Question: Write a caption explaining this figure to a reader.
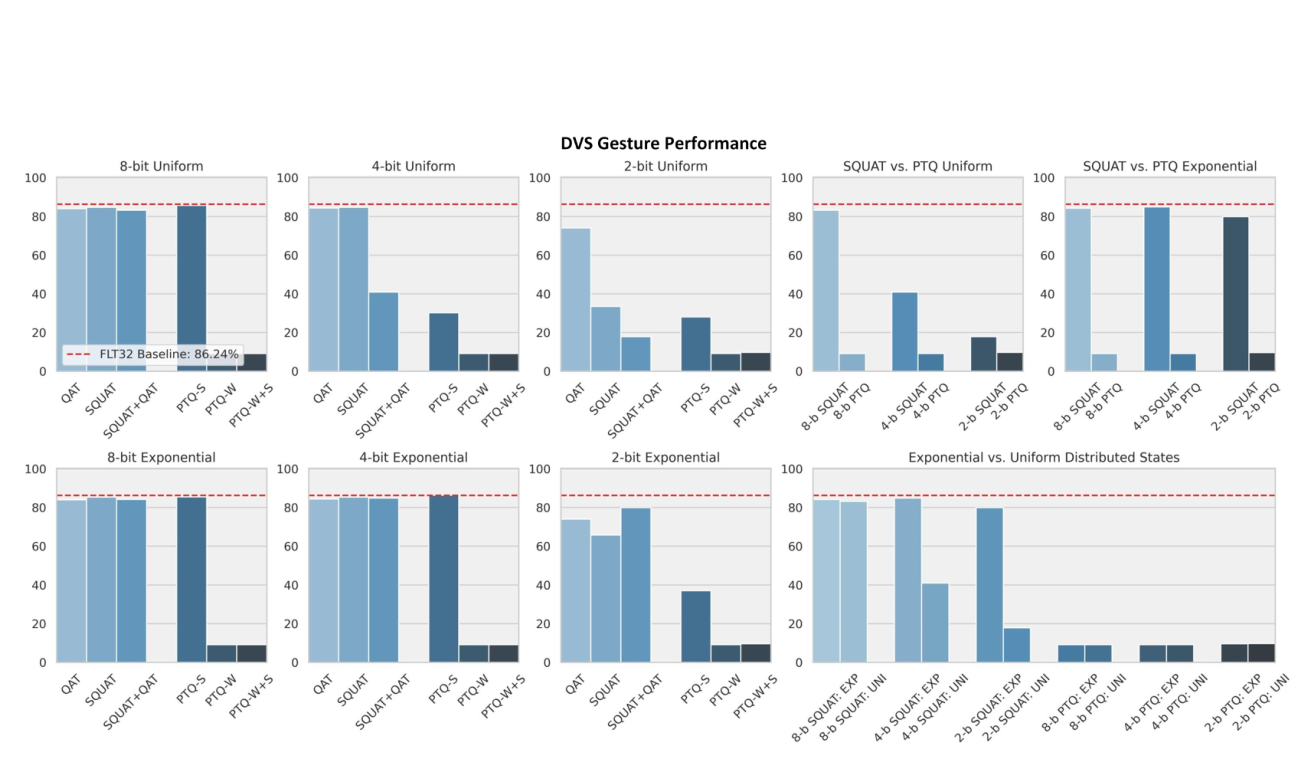
Answer: DVS Gesture Dataset performance. Top row: (i) 8/4/2-b uniformly distributed states across QAT (N-b weights, flt32 states), SQUAT (flt32 weights, N-b states), SQUAT+QAT (N-b weights, N-b states), and PTQ-S (flt32 weights, N-b states), PTQ-W (N-b weights, flt32 states), PTQ-W+S (N-b weights, N-b states). (ii) SQUAT vs PTQ uniformly and exponentially distributed states (SQUAT and QAT are both applied across N-b weights and states, and compared against PTQ of N-b states and weights). Bottom row: (iii) 8/4/2-b exponentially distributed states across QAT (N-b weights, flt32 states), SQUAT (flt32 weights, N-b states), SQUAT+QAT (N-b weights, N-b states), and PTQ-S (flt32 weights, N-b states), PTQ-W (N-b weights, flt32 states), PTQ-W+S (N-b weights, N-b states). (iv) Comparison between exponential and uniformly distributed states: SQUAT+QAT are used across N-b states and weights, then N-b PTQ is used across N-b states and weights.